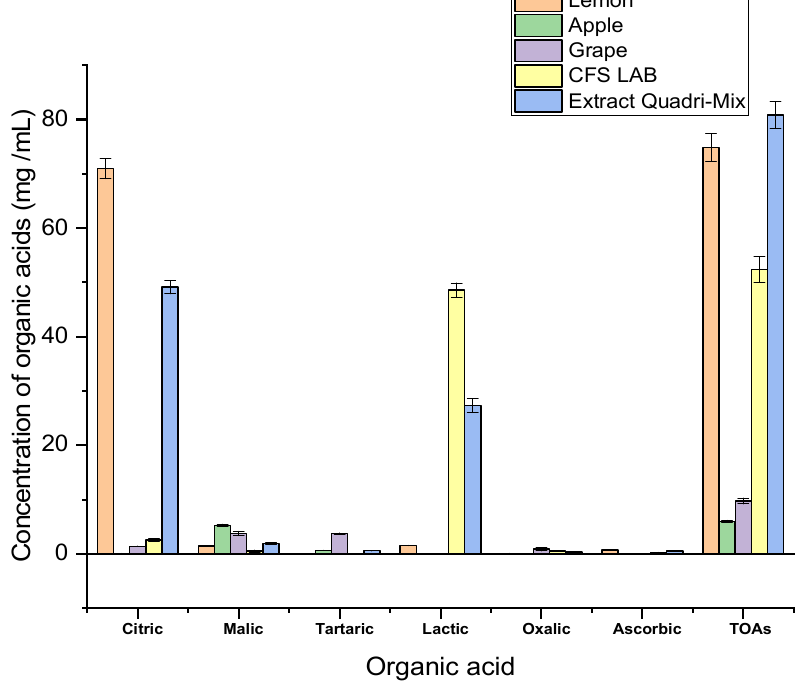
Figure 1. Concentrations of organic acids in lemon, apple, grape, cell-free supernatant of L. acidophilus , and quadri-mix extract (lemon + apple + grape + cell-free supernatant of L. acidophilus ) determined by HPLC (mg/mL). TOAs (total organic acids), CFS LAB (cell-free supernatant of lactic acid bacteria).